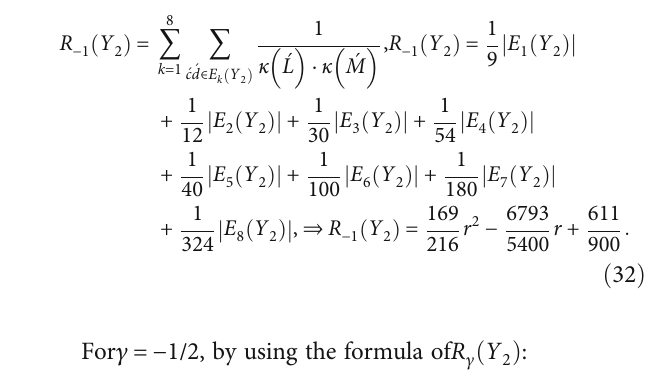
Figure 8: Comparison of indices for RHDN4 ð 4, 4 Þ